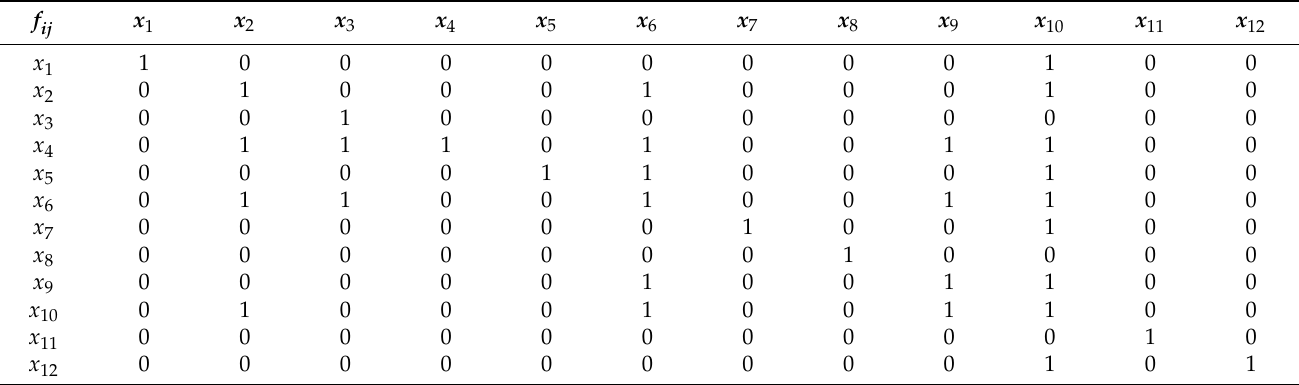
Table 6. Reachable matrix F .